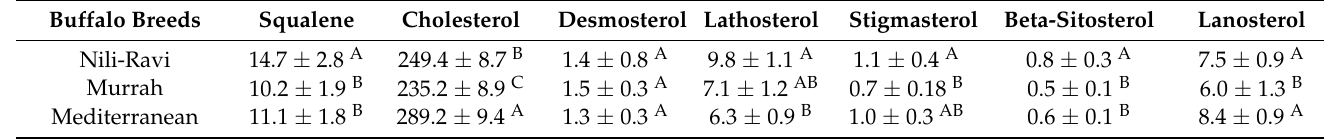
Table 4. Sterol contents of milk of different breeds (mg/100 g).